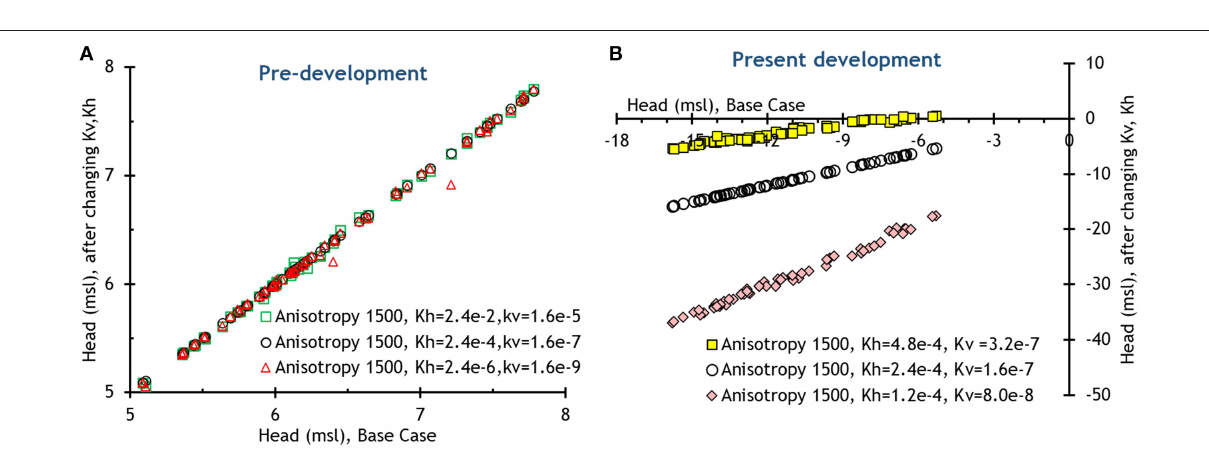
prominent in the distribution of heads in the Quaternary confined aquifer. The regional groundwater flow is toward SSE. A local groundwater mound (defined by 8 m above msl piezometric surface contour) has formed in the central-western part of the study area over the Domjur and Sankrail blocks ( Figure 7